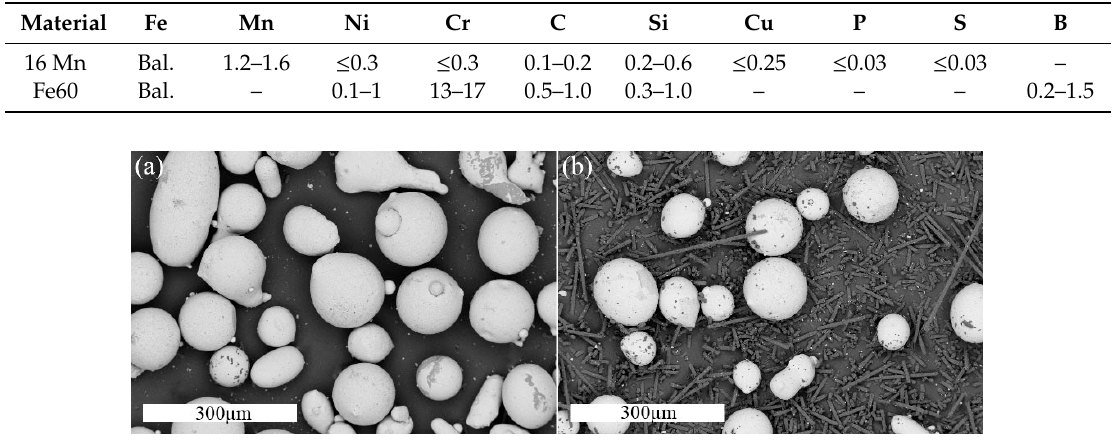
Figure 1. The morphologies of the Fe60 ( a ) and Fe60/CFs powder mixtures ( b ). After that, a Laserline laser cladding system (LDF4000-100, Redmond, WA, USA), a high-power continuous-wave semiconductor laser with a wavelength of 980 nm, was used for laser cladding in this investigation. The laser beam was adjusted into a rectangle laser spot with size of 12 mm × 3 mm